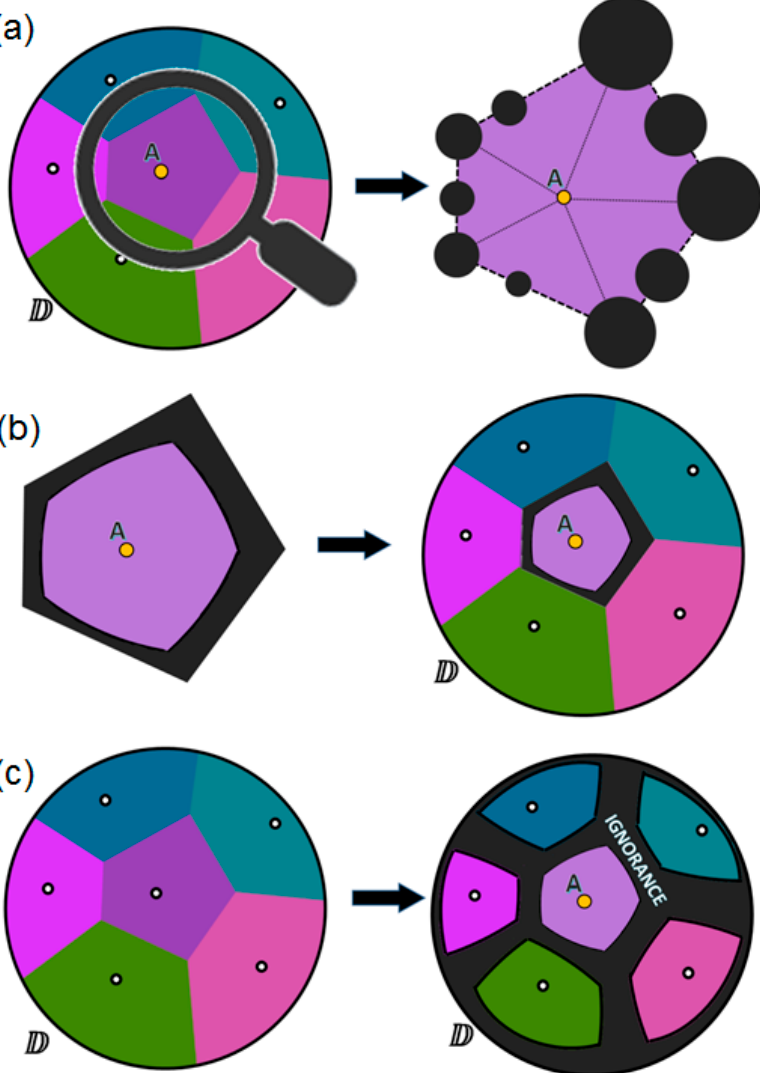
Figure 11. The example of the Voronoi diagram evolution towards the ignorance-aware Voronoi diagram: ( a ) the ignorance zones are computed separately for each Voronoi cell, which works as a small domain with generating point in it; ( b ) the ignorance zones within each cell are merged into the ignorance area around the point leaving also some space for a zone of believed certainty; ( c ) the same is done for all the Voronoi cell resulting to the ignorance-aware Voronoi diagram.